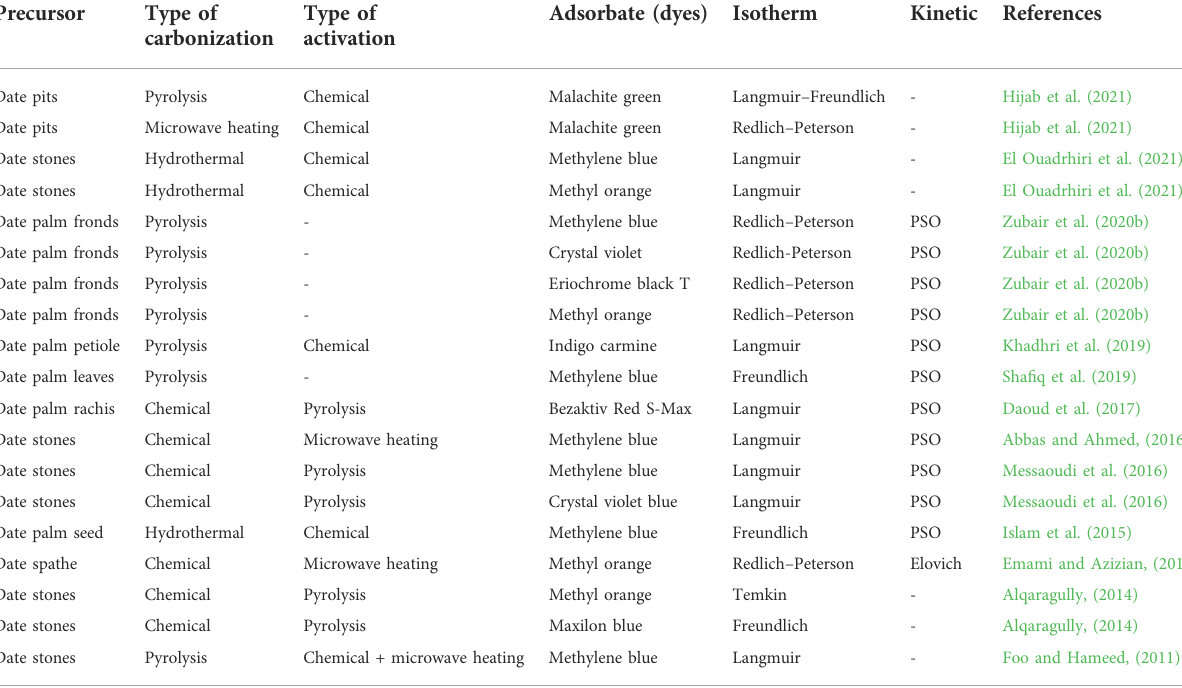
TABLE 9 Summary of isotherm and kinetic models for textile dye removal by date palm residue-based activated